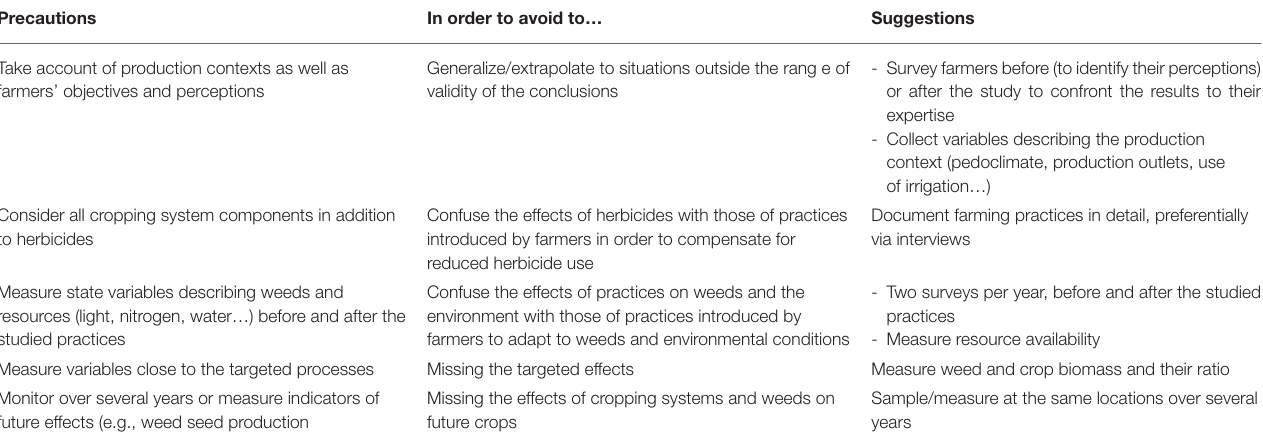
FIGURE 3 | Conceptual representation of cropping system effects on weeds and crop production in farmers’ fields inspired by structural equation modeling to synthesize the relationships between herbicide use intensity, weed pressure, and yield loss based on the present literature analysis. Circles show latent variables (in bold the targets investigated in the present study), and rectangles manifest variables. The gray zone delimits the cropping system. Note that the arrows point from the latent variables to the manifest variables. Red arrows are effects of cropping system components (a. to create favorable conditions for crop growth, b. to create unfavorable conditions for weeds and to destroy them; c. phytotoxicity, d. weed destruction); green arrows show environmental effects (1. cropping choices depend on biophysical and socio-economical constraints; 2. crop growth and weed community depend on biophysical environment; 3: yield loss is the difference between attainable and actual yield due to weeds); blue arrows show farmers’ decisions (i. farmers choose cropping techniques, including herbicides, based, among others, on their risk aversion; ii: the choice of the herbicide strategy depends on other techniques and vice-versa; iii: the choice of cropping techniques, particularly herbicides, depends on the past and present weed community). Positive ( + ) and negative (–) effects were shown for latent variables. TABLE 5 | Major precautions needed to study the relationships between herbicides, weeds and yield to avoid methodological defects.